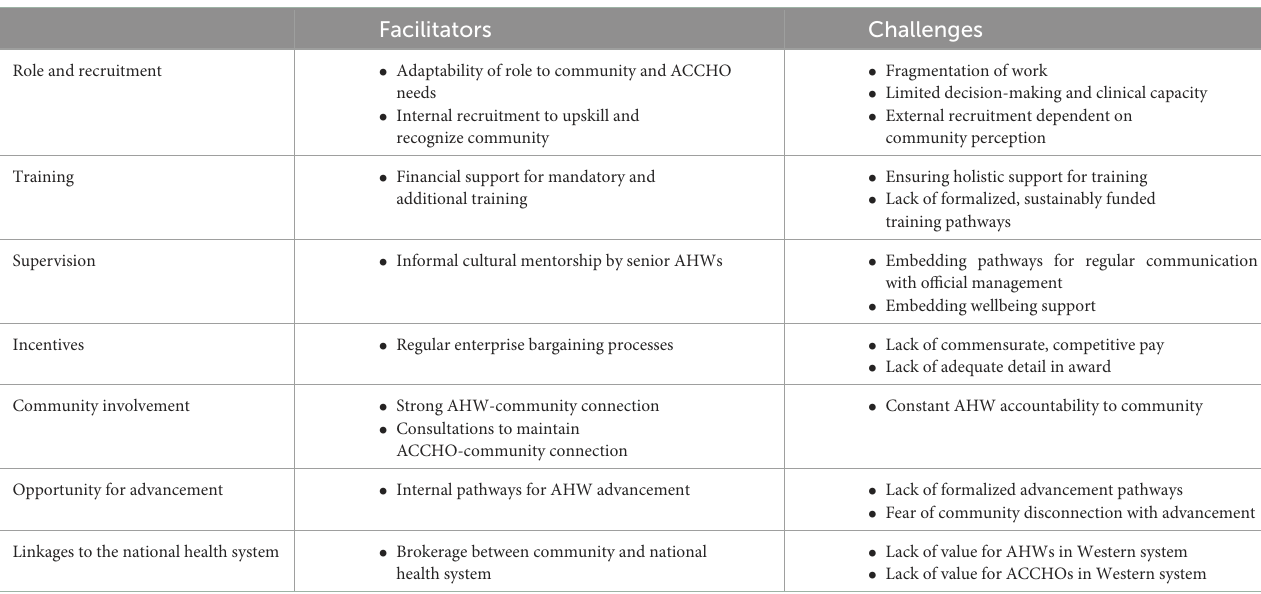
TABLE 2 Facilitators and challenges for AHW sustainability at participating